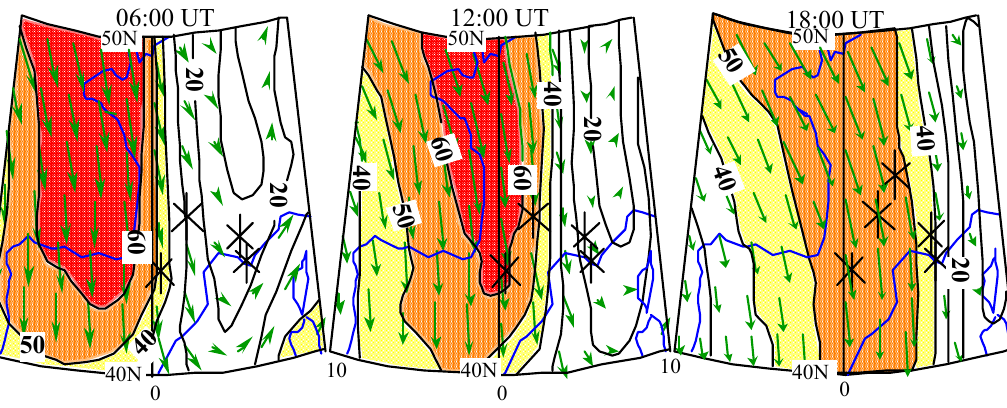
Fig. 2. ECMWF Analysis. Wind field on the 300 hPa isobaric surface, on 4 March 1995 at 0600 (left); 1200 (center) and 1800 UTC (right). The four stars indicate the geographical location of the radars.